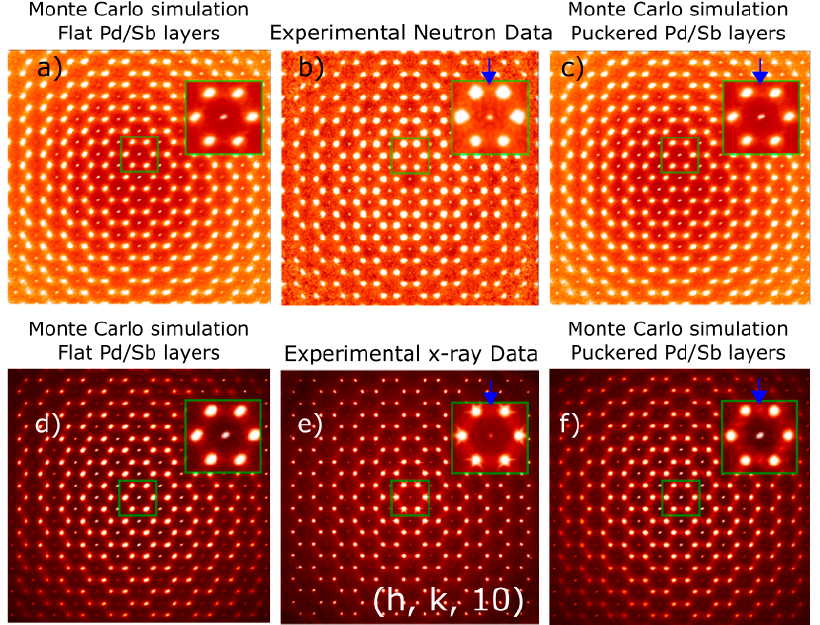
Figure 3. Diffuse scattering for LaPdSb: panels ( b , e ) show neutron and X-ray experimental diffuse scattering for (h, k, 10) layer; panels ( a , c , d , f ) show the simulated diffuse scattering from the balls-and-springs Monte Carlo simulation corresponding to flat Pd/Sb and puckered layers; blue arrows show the presence of experimental features and highlight these features in the diffuse scattering associated with the presence of puckering (Bragg peaks have been subtracted in the MC simulation but not the data); insets show zooms of the region inside the green rectangle.